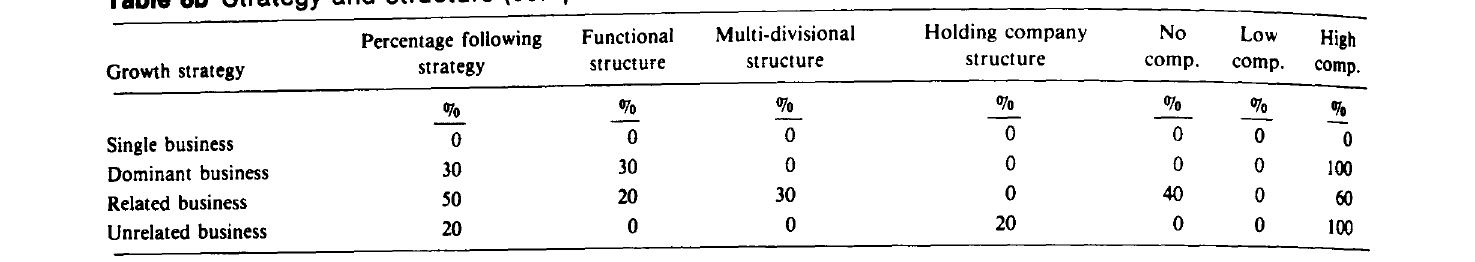
Table Sb Strategy and structure (companies with formal strategic